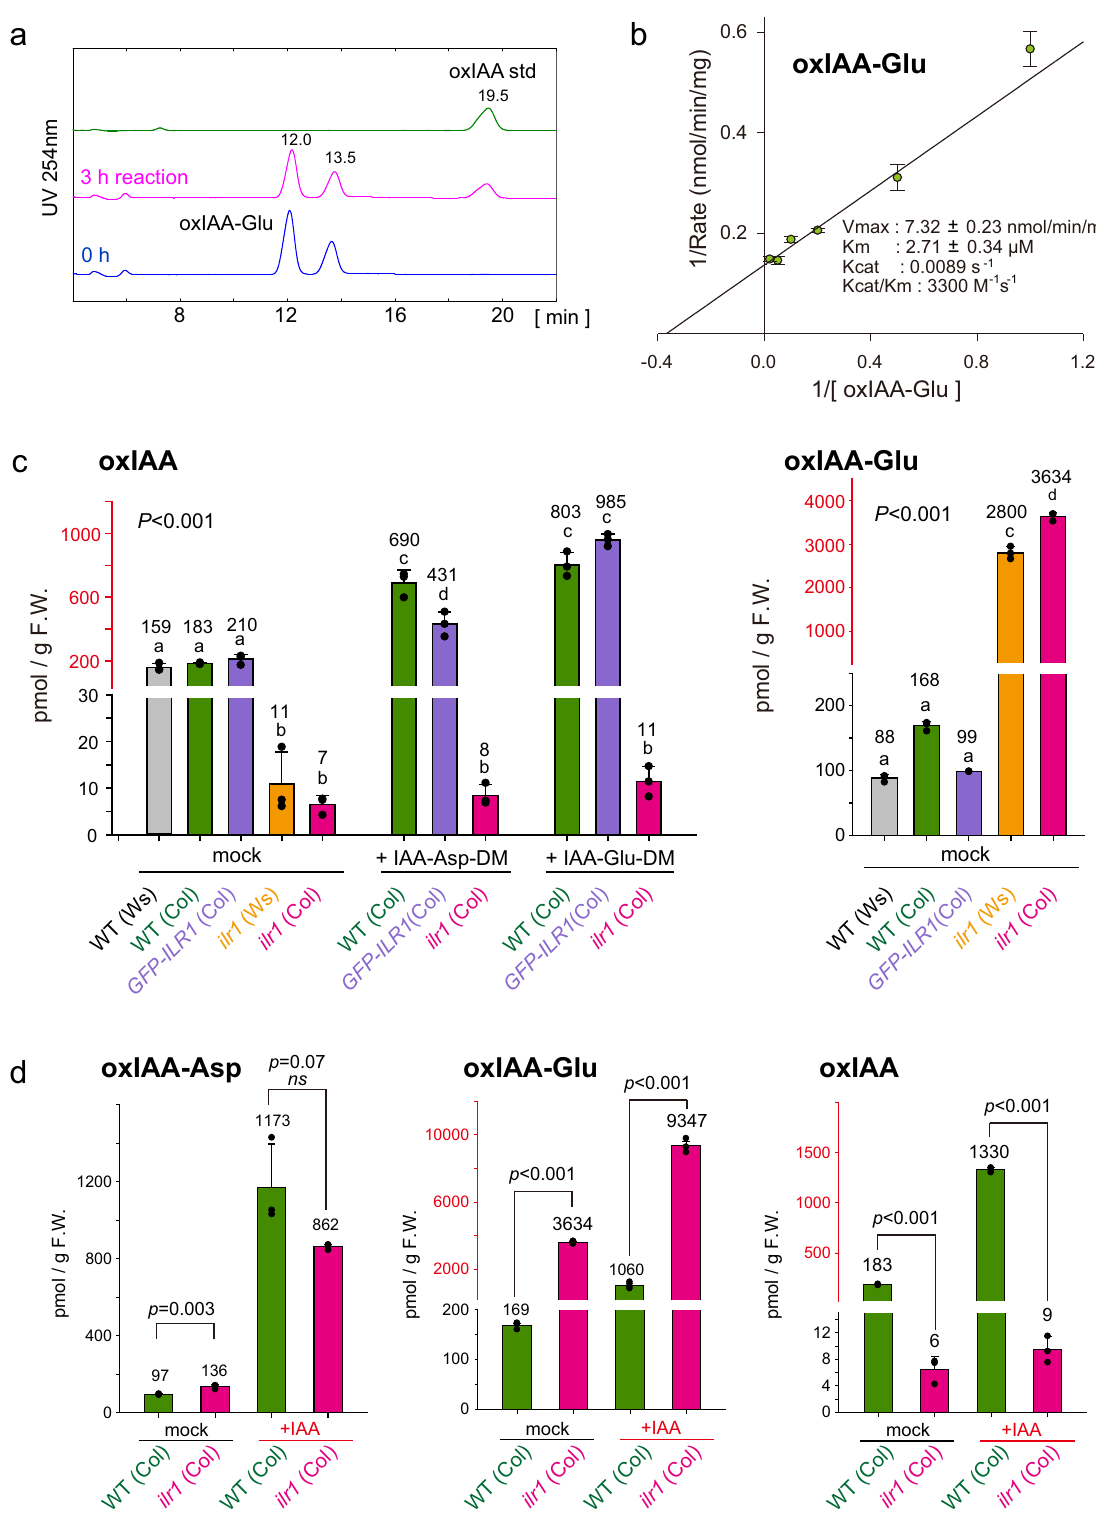
Fig. 6 ILR1 hydrolyzed IAA amino acid conjugates to produce oxIAA. a HPLC chromatogram of the reaction products of the recombinant GST-ILR1 enzyme. b Lineweaver-Burk plot and kinetics parameters of GST-ILR1 for oxIAA-Glu as the substrate ( n = 4). c The endogenous levels of oxIAA and oxIAA- Glu in WT, ilr1-1 (Ws, EMS mutant), ilr1 (Col, SAIL_631_F01) and pILR1::ILR1-GFP in ilr1 (Col) complementation lines. Seven-day-old plants were treated with 0.5 μ M IAA-Asp-DM or IAA-Glu-DM for 20 h. The values shown are the means ± SD ( n = 3). The different letters represent statistical signi fi cance at P < 0.001 (Tukey ’ s HSD test). d The endogenous levels of oxIAA-Asp, oxIAA-Glu, and oxIAA in WT and ilr1 (Col) seedlings. Seven-day-old plants were treated with 0.5 μ M IAA for 24 h. The values shown are the means ± SD (two-tailed Student ’ s t test, n =